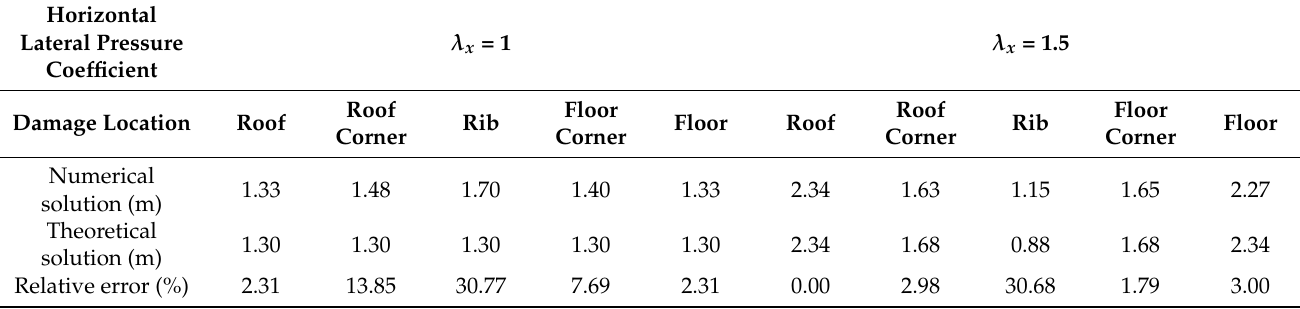
Table 2. Theoretical and numerical solutions of plastic zone range in the two-dimensional circular